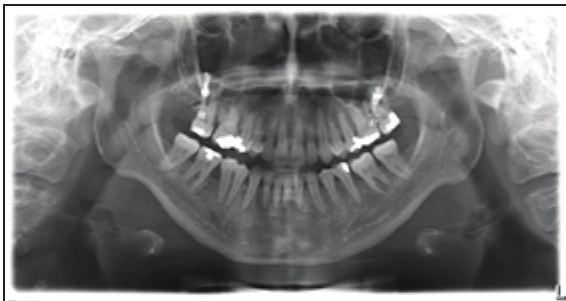
Figure 9. Post-treatment panoramic radiograph of the patient.